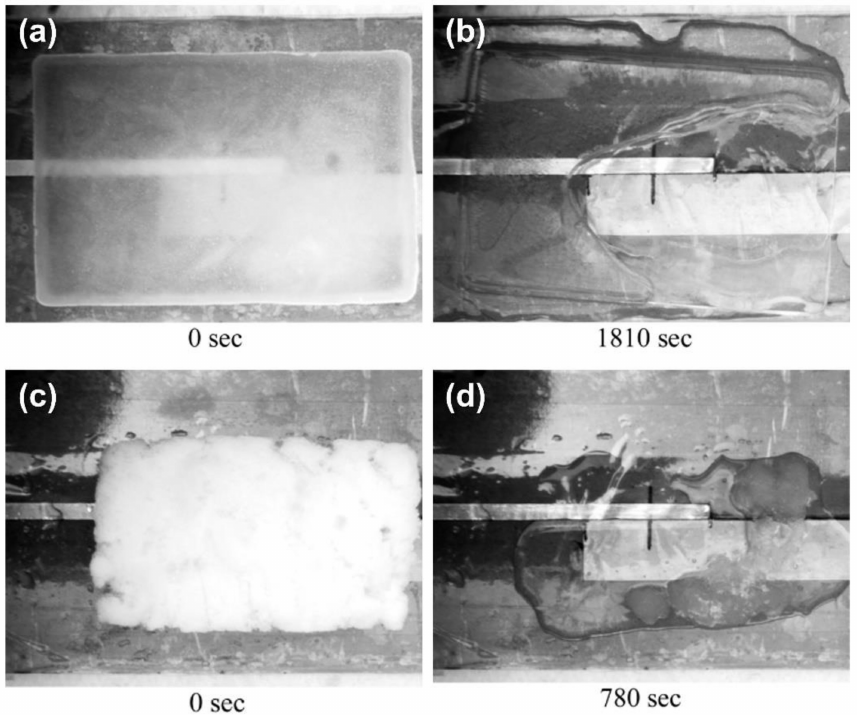
Figure 26. Time evolution of the deicing process of ice ( a , b ) and soft ice ( c , d ) layers (adapted from Abdollahzadeh et al. [111] with permission under Creative Commons